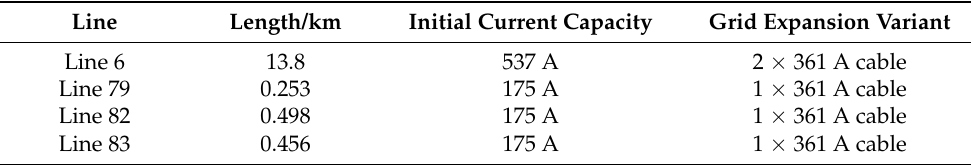
Table 10. Results of the grid expansion within the classical grid planning.